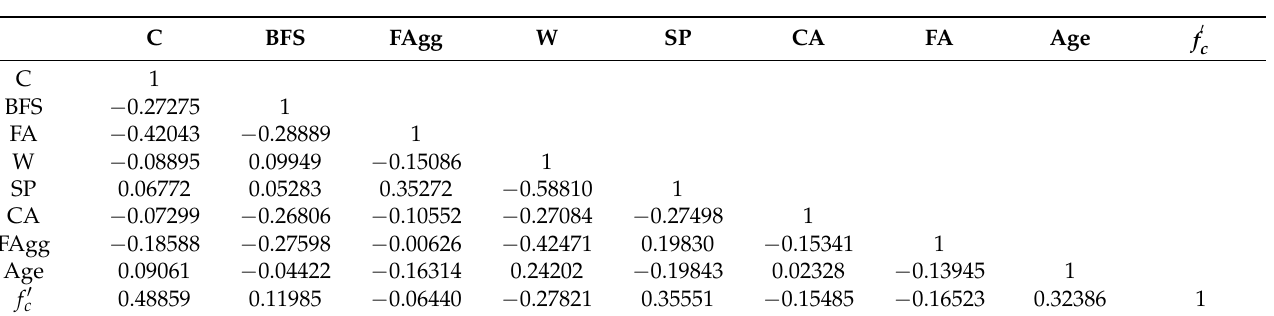
Table 2. Correlation matrix.